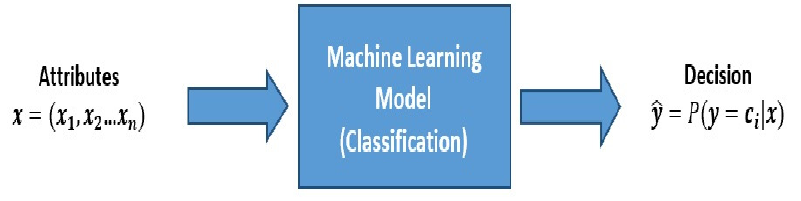
Figure 3. Machine learning-based management of health monitoring services allocation.